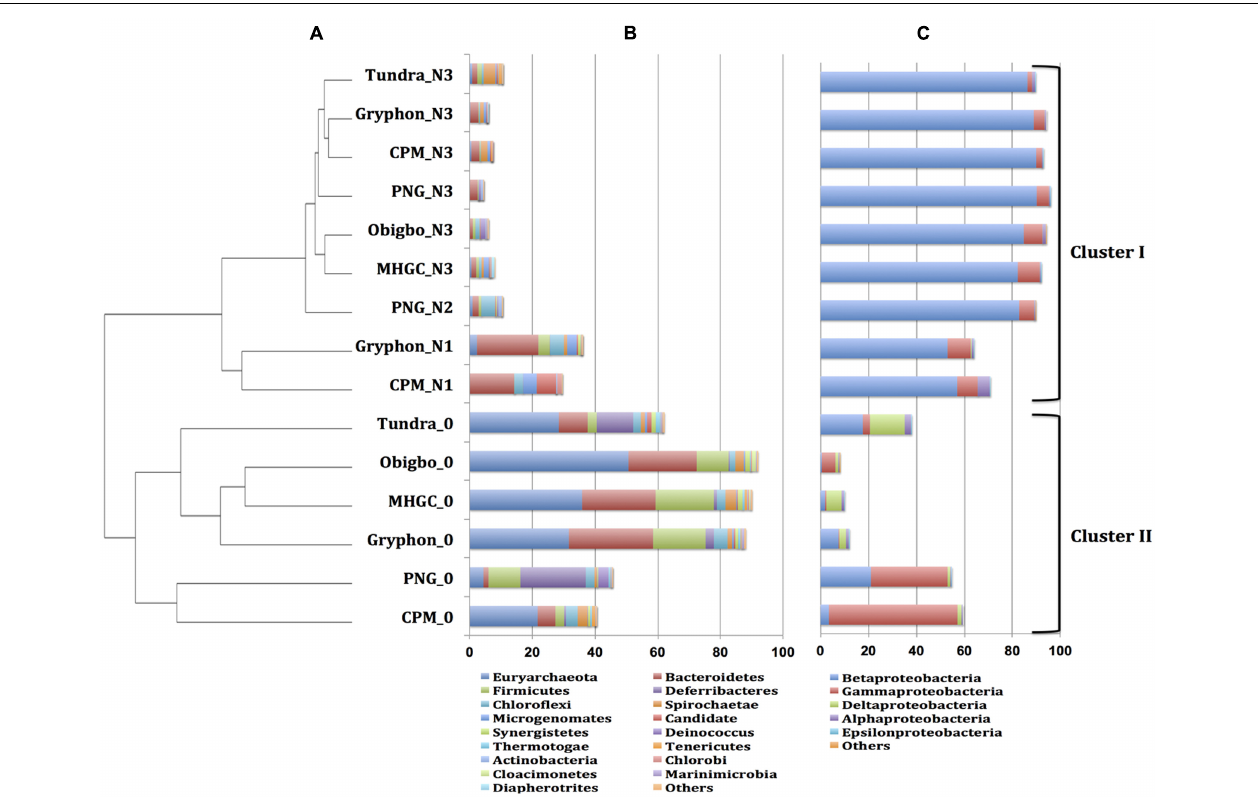
FIGURE 7 | Comparison of microbial community compositions derived from 16S rRNA amplicons of hNRB incubations with oils. (A) Relational tree generated using the UPGMA algorithm in MetaAmp. Microbial community compositions are represented at (B) at the phylum level excluding Proteobacteria and (C) at the class level for Proteobacteria only. Data are for incubations with the indicated oils without nitrate (0), with 10 mM nitrate (N1), with 10 and 20 mM nitrate (N2) or for incubations with additional toluene and 10, 20, 40, and 80 mM nitrate (N3), as in Figure 5 ; chromosomal DNA’s for these latter incubations with a given oil were